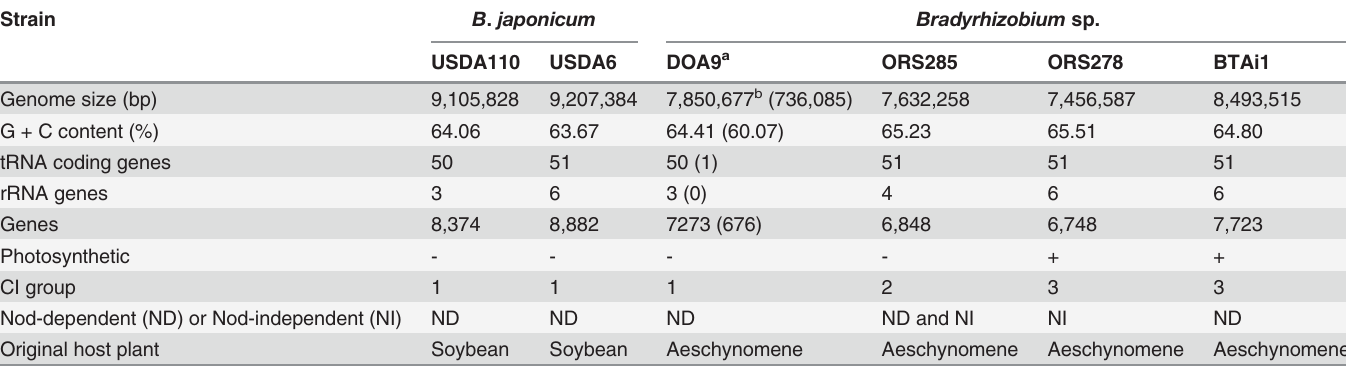
Table 1. General genome features of DOA9 and related bradyrhizobiaceae